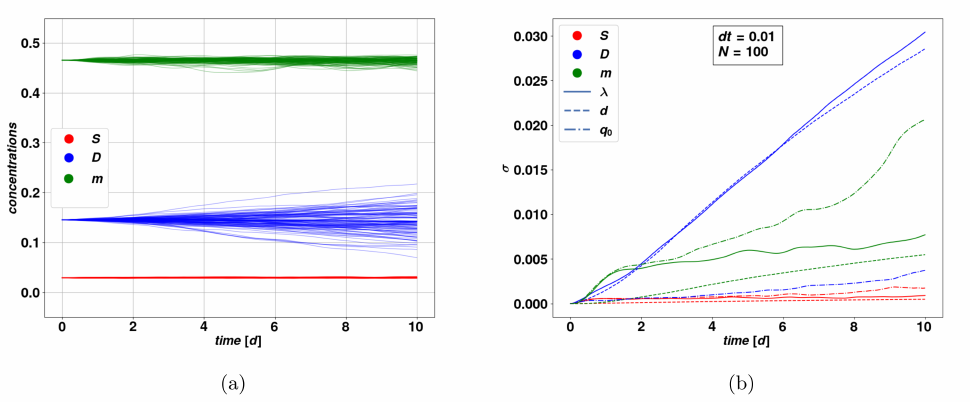
Figure 3. Study of the stochastic trajectories in neighborhood of fixed point F 2 . On the left ( a ) displays a bundle of N = 100 stochastic trajectories, whereby the fluctuating parameter is λ . On the right ( b ) shows the accretion of the bundle width over time for the dynamical parameters of the system subject to stochastic noise on each of the parameters λ , d and q 0 . The bundle width is quantified by the standard deviation σ of the distribution of the trajectories at each point in time. σ is estimated for each variable using an unbinned maximum likelihood fit of a Gaussian distribution, of which σ equals the fitted standard deviation. As previously, we display in blue the concentration D of differentiated cells, in red the concentration S of CSCs, and in green the plasticity signaling concentration. The variable a is not displayed since it corresponds to a numerical zero and undergoes no variation even in the stochastic trajectories. The stochastic bundle is pictured as the thin solid line. The style in b depends on the choice of stochastic variable: continuous line for λ , dashed line for the death rate d and dot-dashed for the plasticity coefficient q 0 . The fluctuating parameters evolve according to an unbiased Wiener process, starting from fixed base values. In each trajectory, the noise amplitude is of 10% of the base value. We see how most amplitudes grow